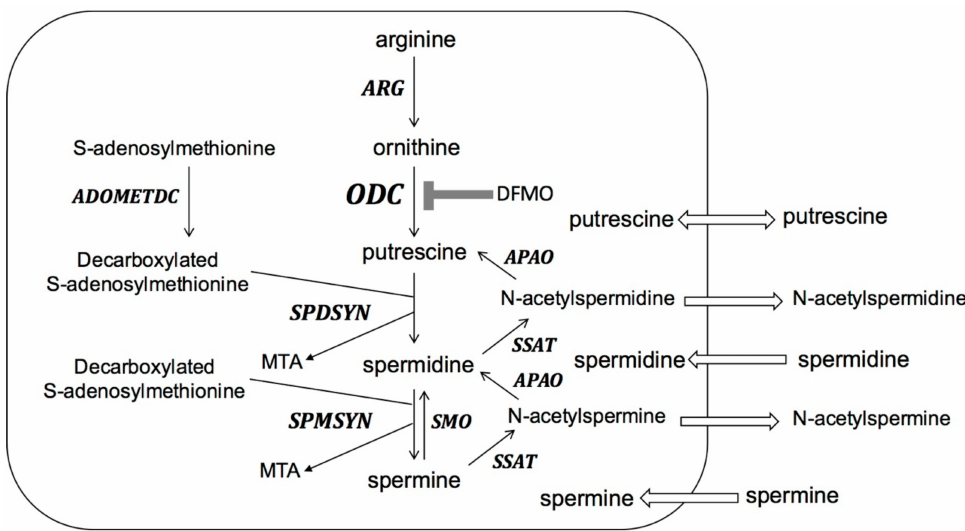
Figure 2. The polyamine pathway in mammalian cells. ARG: arginase; ODC: ornithine decarboxylase; SPDSYN: spermidine synthase; SPMSYN: spermine synthase; ADOMETDC: S-adenosylmethionine decarboxylase; SMO: spermine oxidase; SSAT: spermidine/spermine N1-acetyltransferase; APAO: N-acetyl polyamine oxidase; MTA: methylthioadenosine. Polyamine biosynthesis through ARG, ODC, SPDSYN, SPMSYN and ADOMETDC is shown. Back-conversion from spermine to spermidine occurs through the action of SMO and back-conversion from spermine to spermidine and putrescine is catalyzed by SSAT and APAO. Export of putrescine and acetylated polyamines and import of polyamines from the extracellular milieu are indicated. DFMO inhibition of ODC is